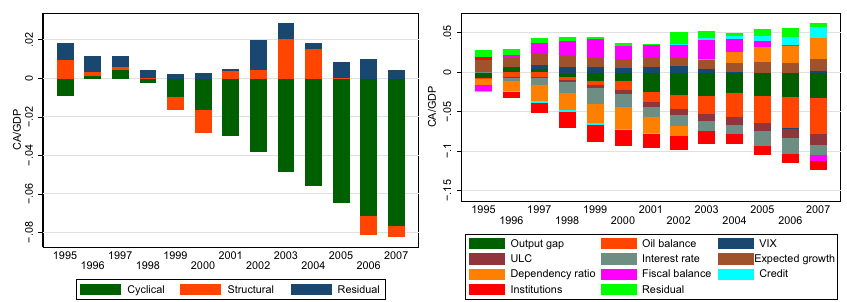
Fig. 4 Accumulated current account deterioration for Spain. Notes. The left panel plots the cyclical and structural components of the Spanish current account 1995–2007 deterioration together with the accu- mulated residual term identified from Eq. (3). The right panel plots the detailed decomposition with the contribution of each of the regressors included in the analysis (oil balance also includes oil prices)